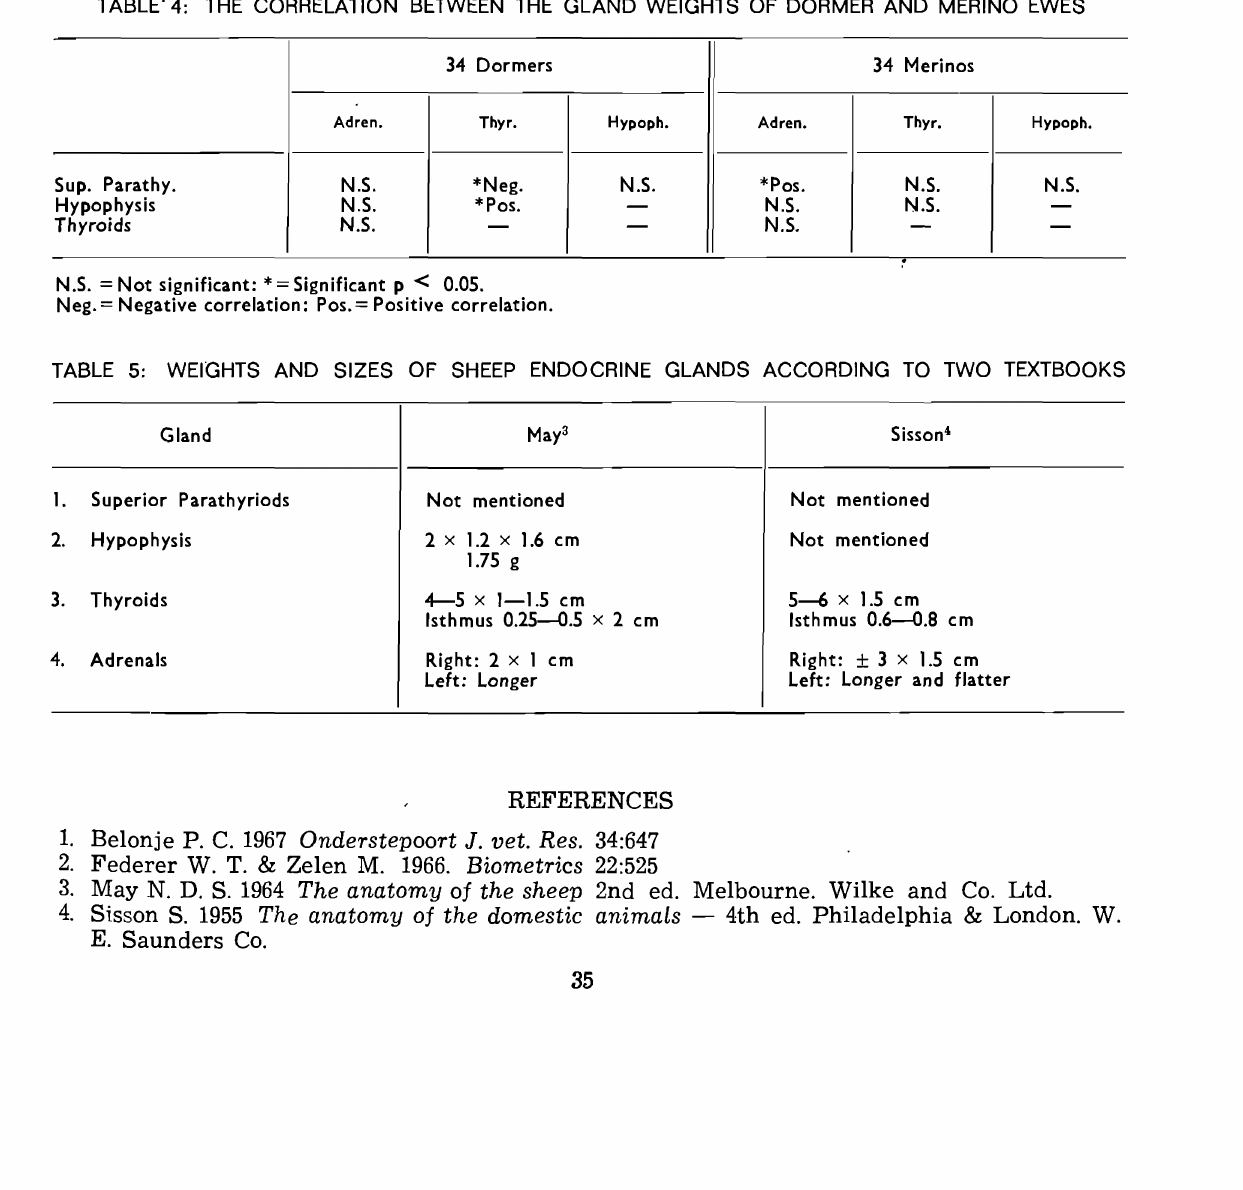
TABLE' 4: THE CORRELATION BETWEEN THE GLAND WEIGHTS OF DORMER AND MERINO EWES 34 Dormers 34 Merinos Ad,en. Thy,. Hypoph. Ad,en. Thy,. Hypoph. Sup. Parathy.